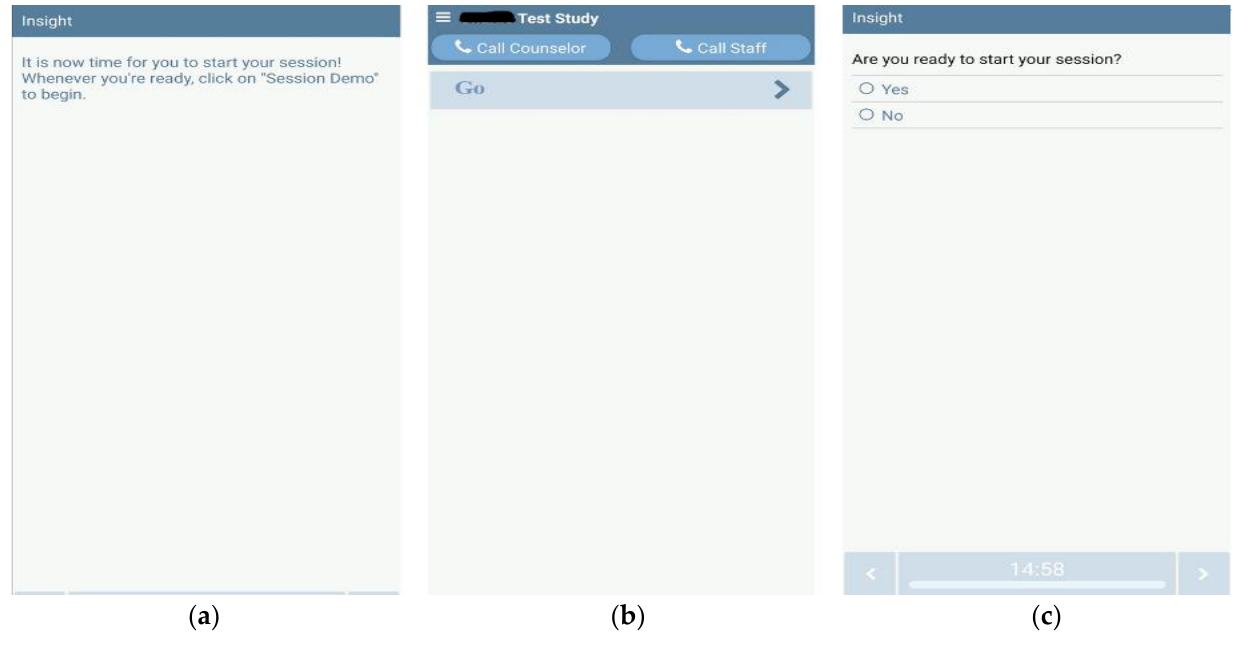
Figure 6. User interface over the Android Bluetooth app. Left — ( a ) The user receives a push notification reminder, which takes them to the app. Middle — ( b ) The “Go” button for the users to start the vibration therapy after they receive the notification. Right — ( c ) If confirmed by yes, the prescribed vibration therapy protocol starts running the focal vibration pods. This helps to prevent accidental activation.